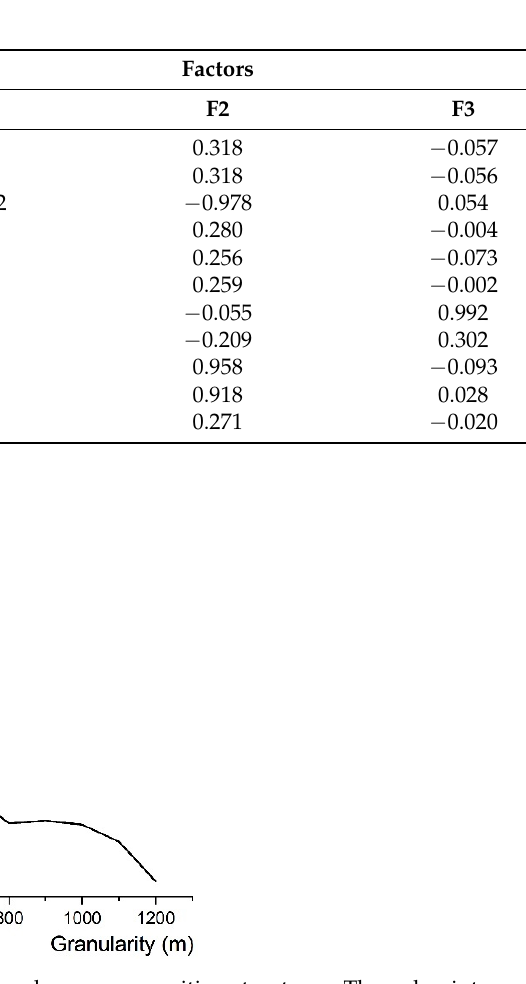
Figure 5. Composite-score line chart of landscape-composition structures. The red point represents the threshold granularity at which the score peaked with a suitable structure.